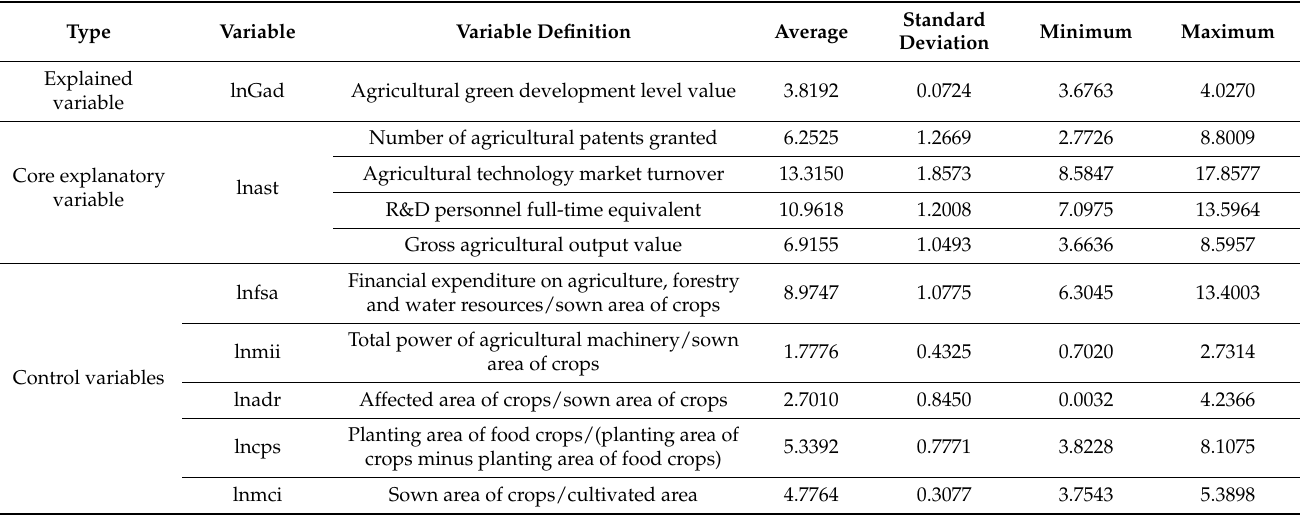
Table 4. Variable description and descriptive statistical